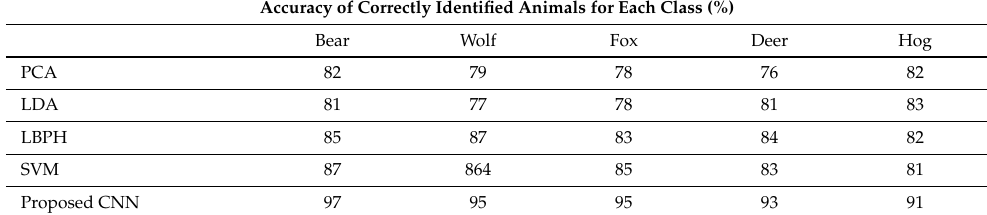
Table 9. Compared results of correctly classified animals from an animal dataset with 5 classes (Results from Tibor et al.